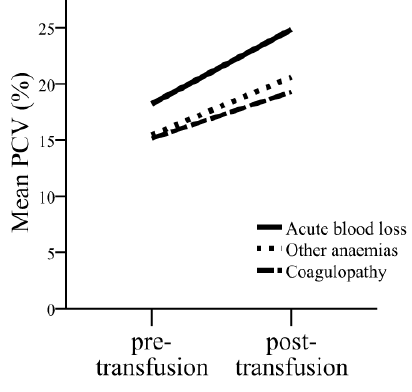
Fig. 1 – Mean PCV before and 12 hours after the transfusion, ac- cording to transfusion indication: acute blood loss ( n = 8 TE), other anaemias ( n = 3 TE) and coagulopathy ( n = 8 TE).